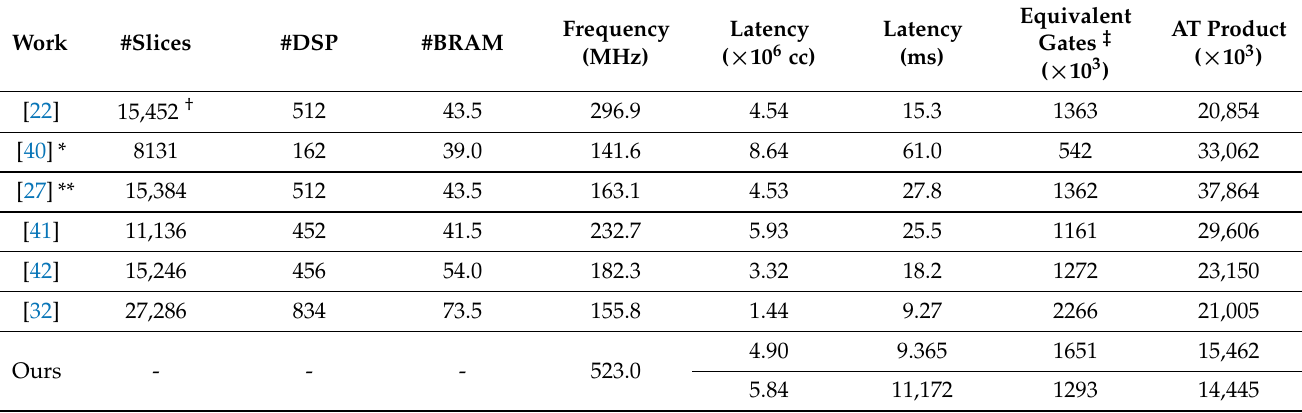
Table 7. Performance comparison with other implementations using the 751-bit prime